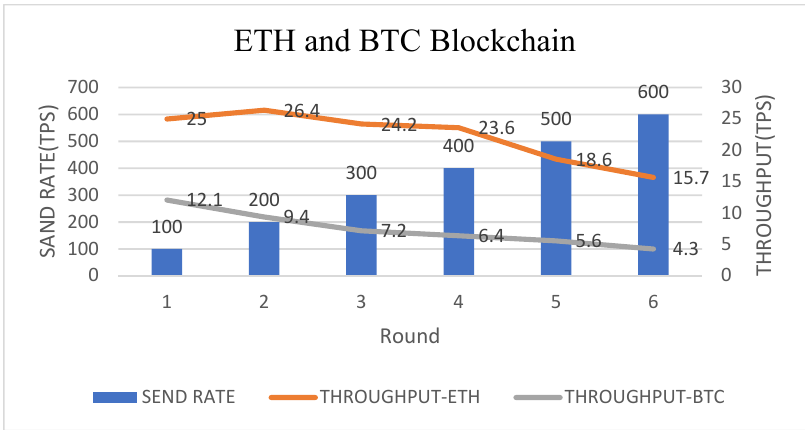
Figure 45. Comparison of transaction volume and throughput in ETH and BTC architecture.